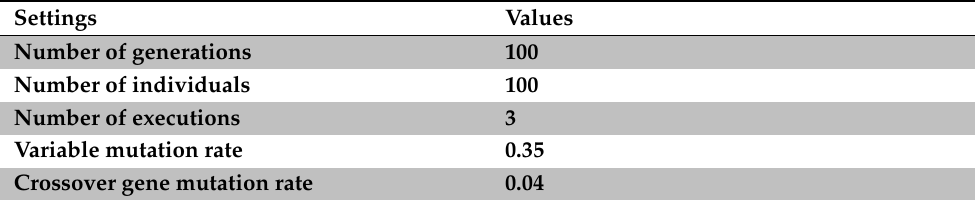
Table 3. Parameters regulation for